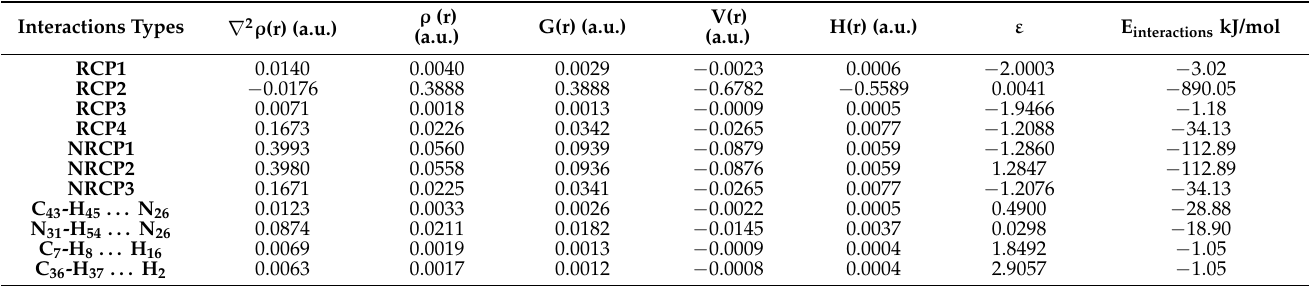
Table 2. AIM topological parameters at BCPs ( ρ : electron density; ∇ 2 ρ : Laplacian of electron density; H: total energy density; V: potential energy density, and E interactions : interaction energy). Interactions